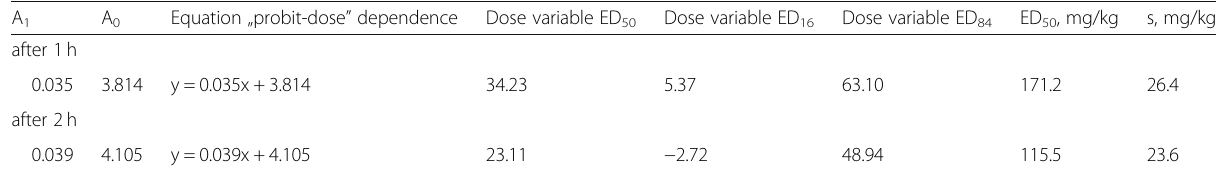
Table 2 Results of calculations for determining ED 50 of dry combined extract BNO 1016 according to anti-inflammatory activity by Probit Analysis